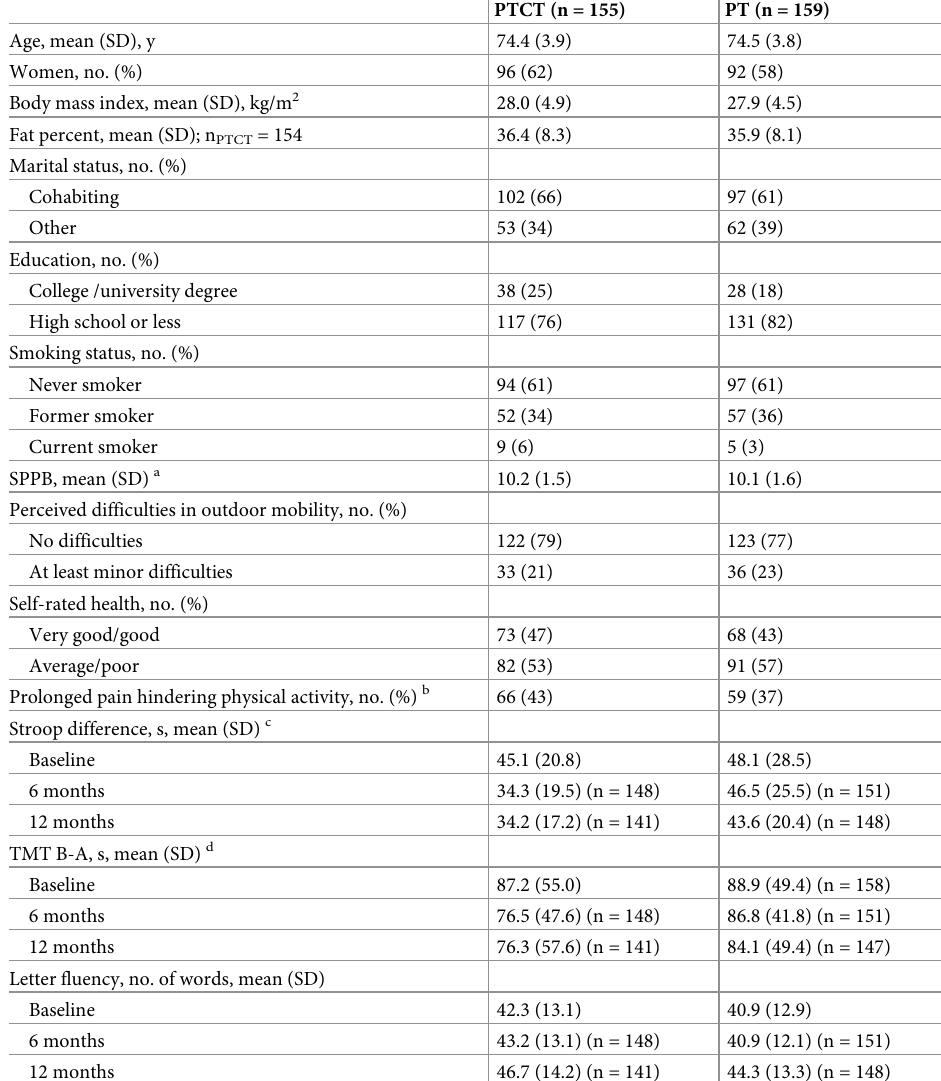
Table 1. Participant characteristics by physical and cognitive training (PTCT) and physical training (PT)